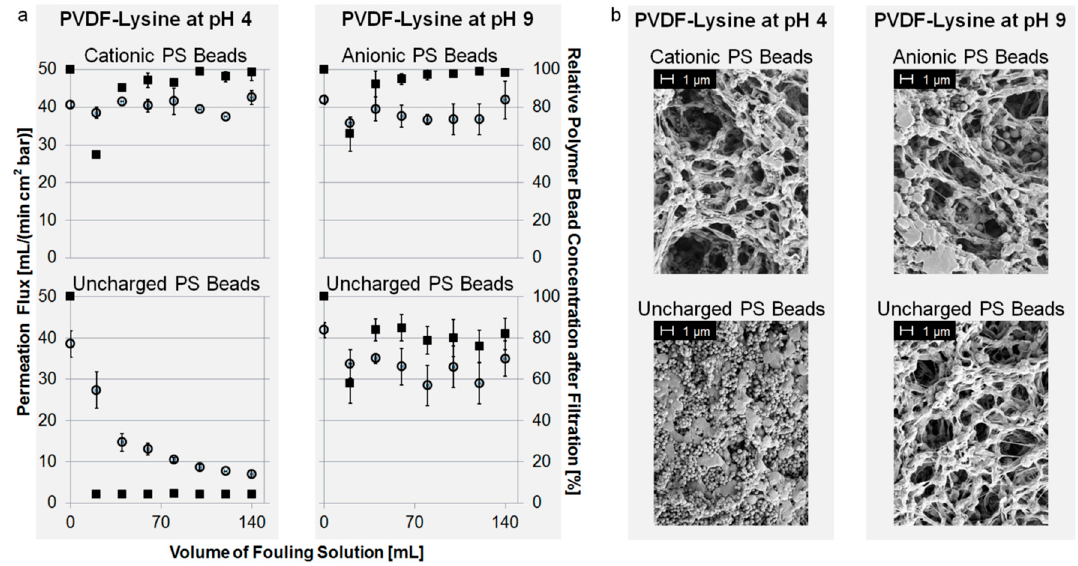
Figure 5. ( a ) Permeation flux of fouling suspension (left axis, open circles) and normalized concentration of PS beads in filtrate (right axis, filled squares) vs. volume of PS bead suspension; and ( b ) SEM pictures of the top side of modified membranes.